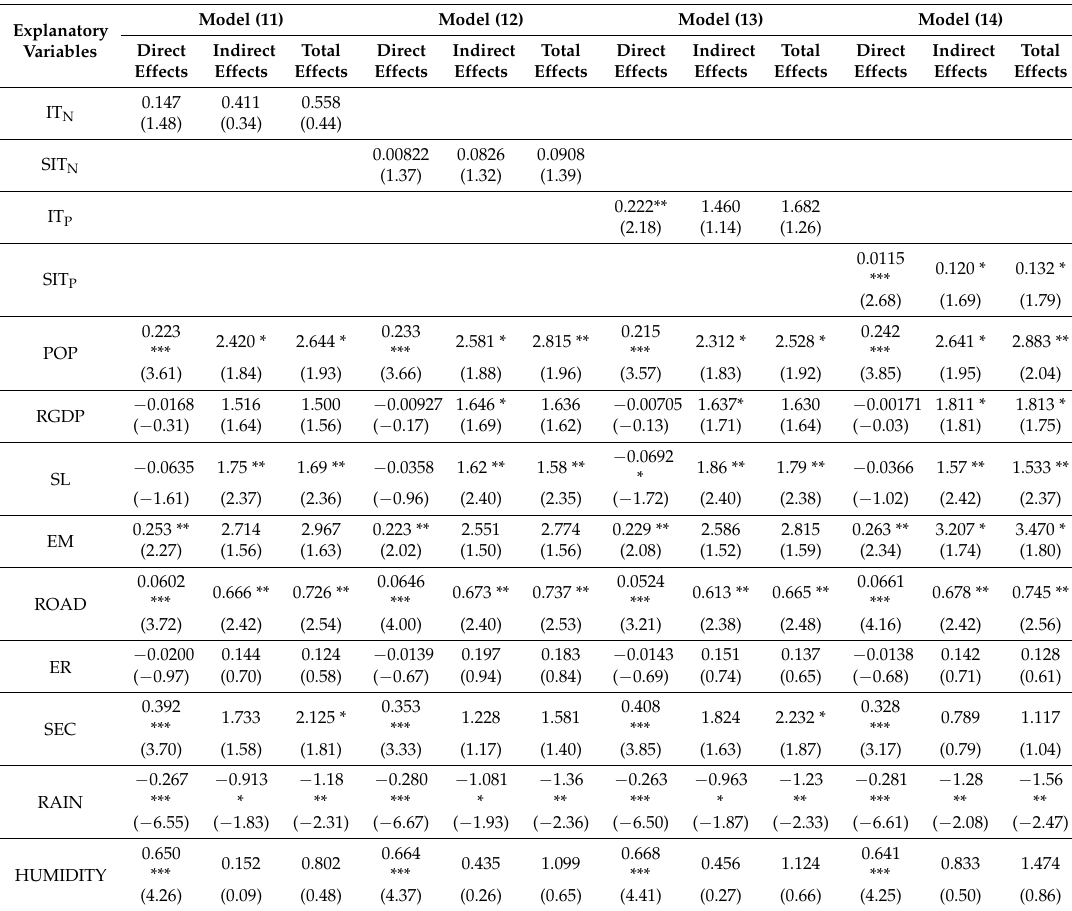
Table 9. Decomposition results of the impact of different industrial transfer on haze pollution. Explanatory